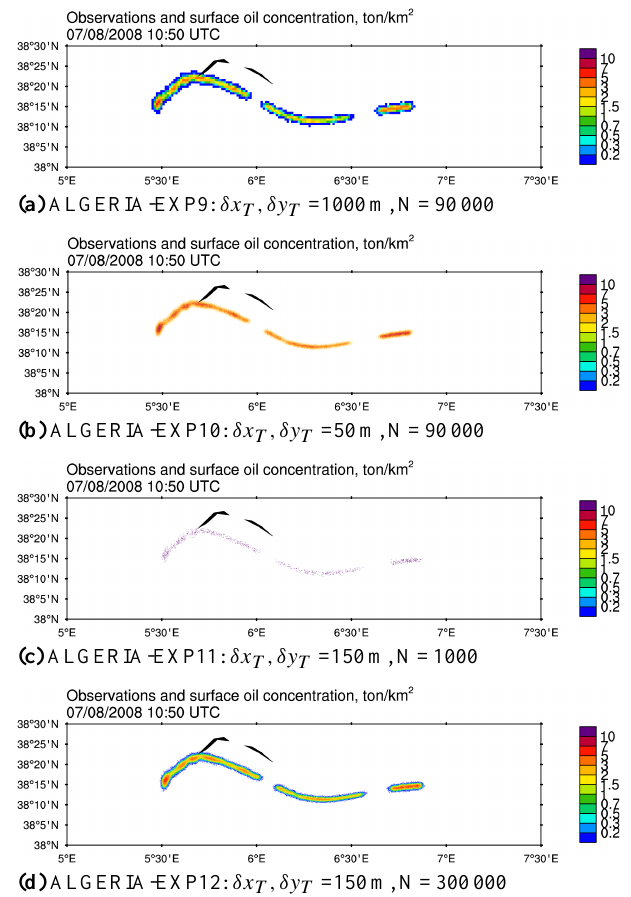
Fig. 12. Results of experiments of the sensitivity to oil tracer grid resolution and number of particles: MEDSLIK-II-predicted position and concentration corresponding to 7 August 2008 at 10:50 UTC compared with the slick observed by